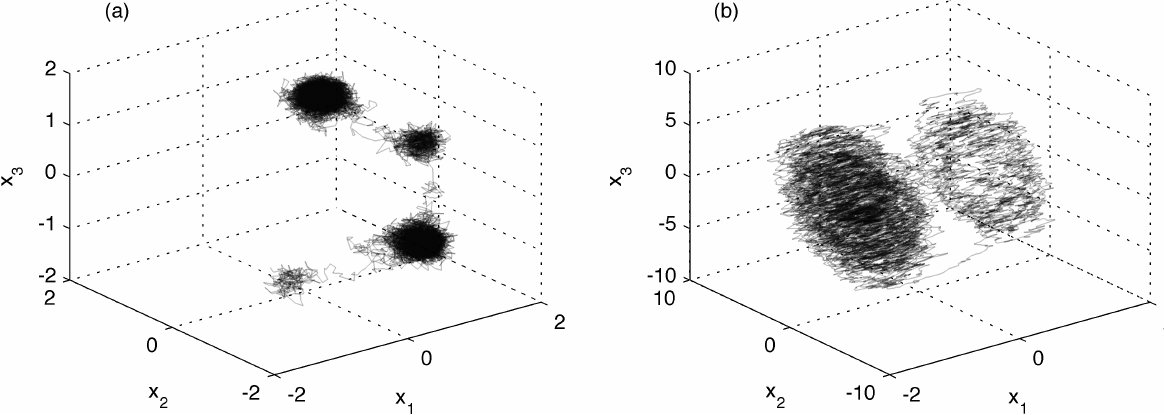
Fig. 3. Examples of three-dimensional projections of the twin solution for the two multiple-well examples: (a) 8 wells with three transitions and (b) two wells with one transition. The number of transitions in the left panel is very rare and is used for visualization purposes.